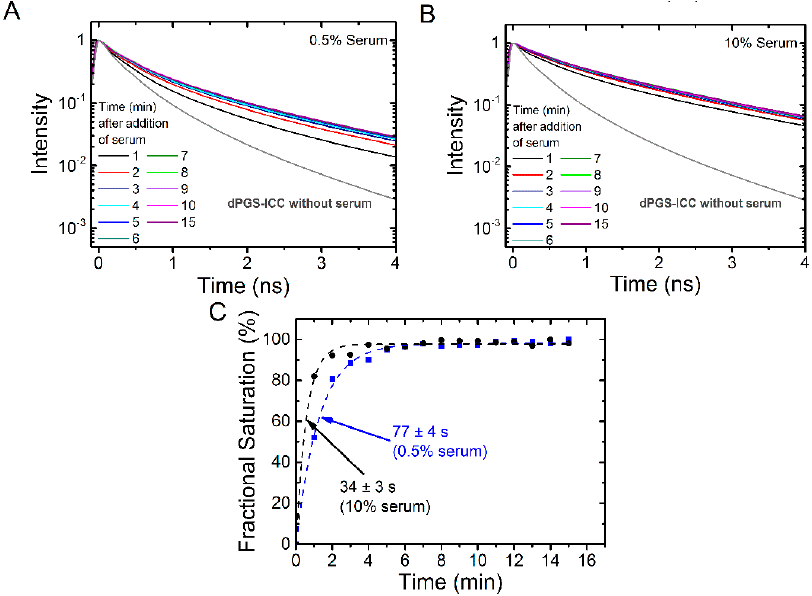
Figure 7. Langmuir binding isotherms of L-selectin ( A ) and C1q ( B ) to dPGS.